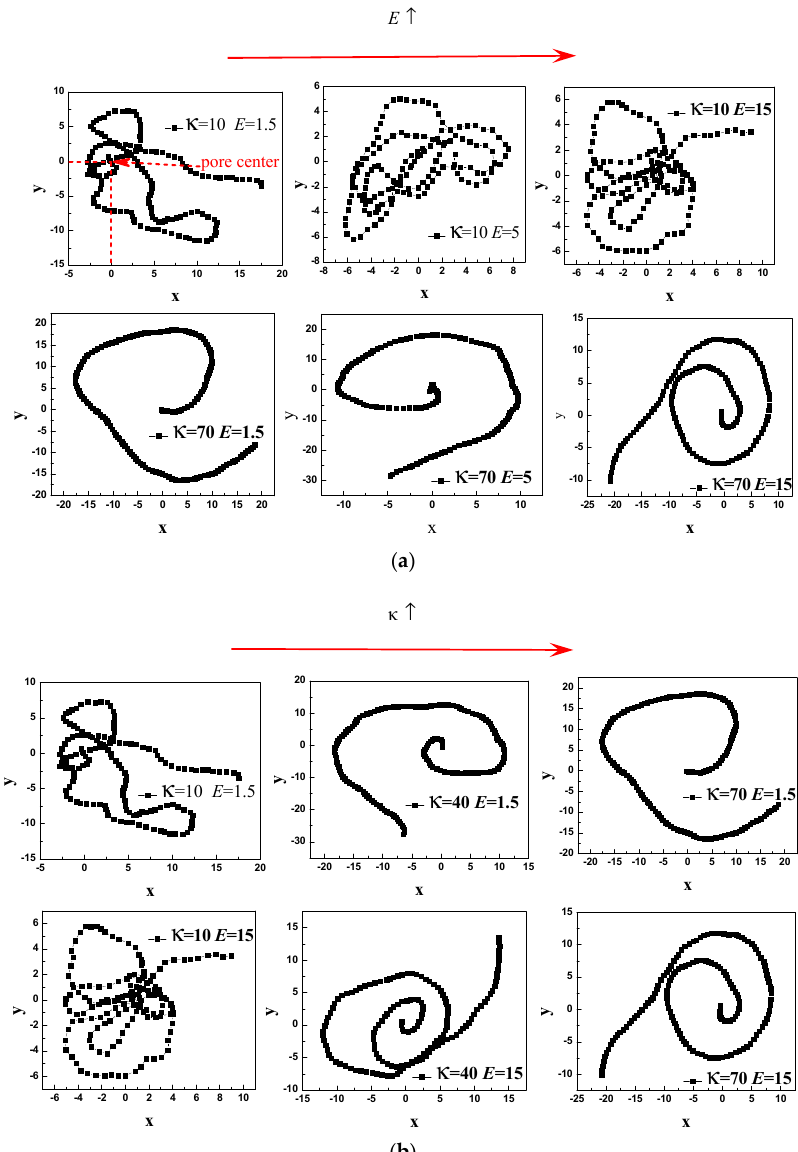
Figure 7. A three-dimensional polymer configuration right after translocation is projected onto the x – y plane for N = 150. The center of nanopore is at x = 0, y = 0. ( a ) The influence of E on the configuration; ( b ) The influence of κ on the configuration.